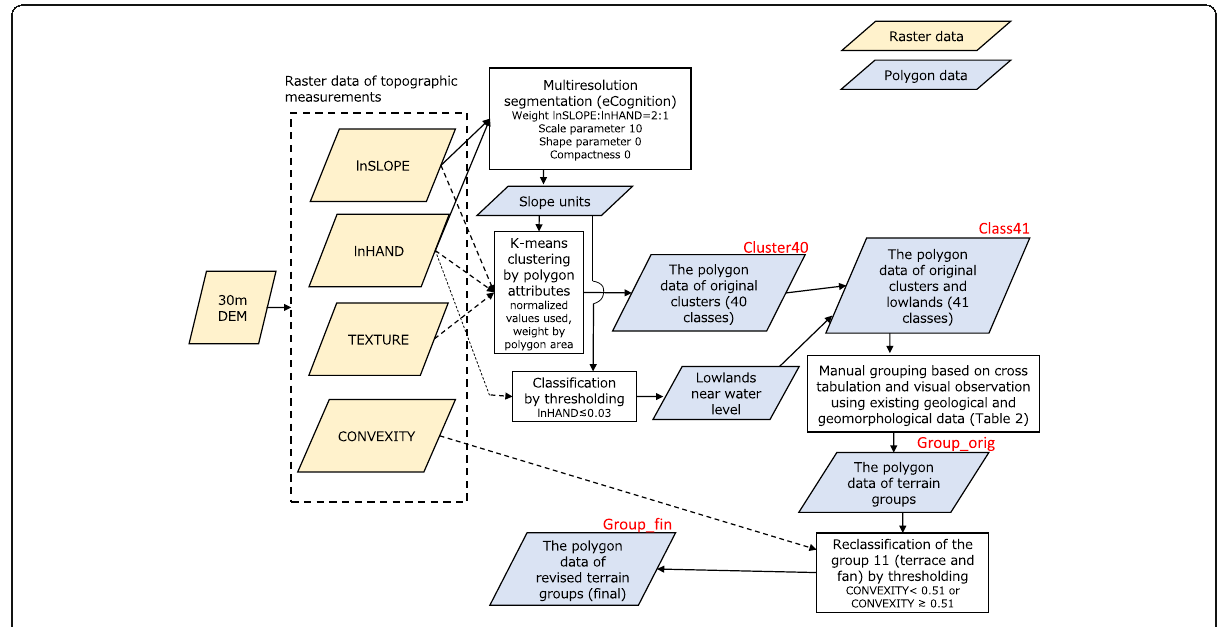
Fig. 7 Outline of the classification method of this